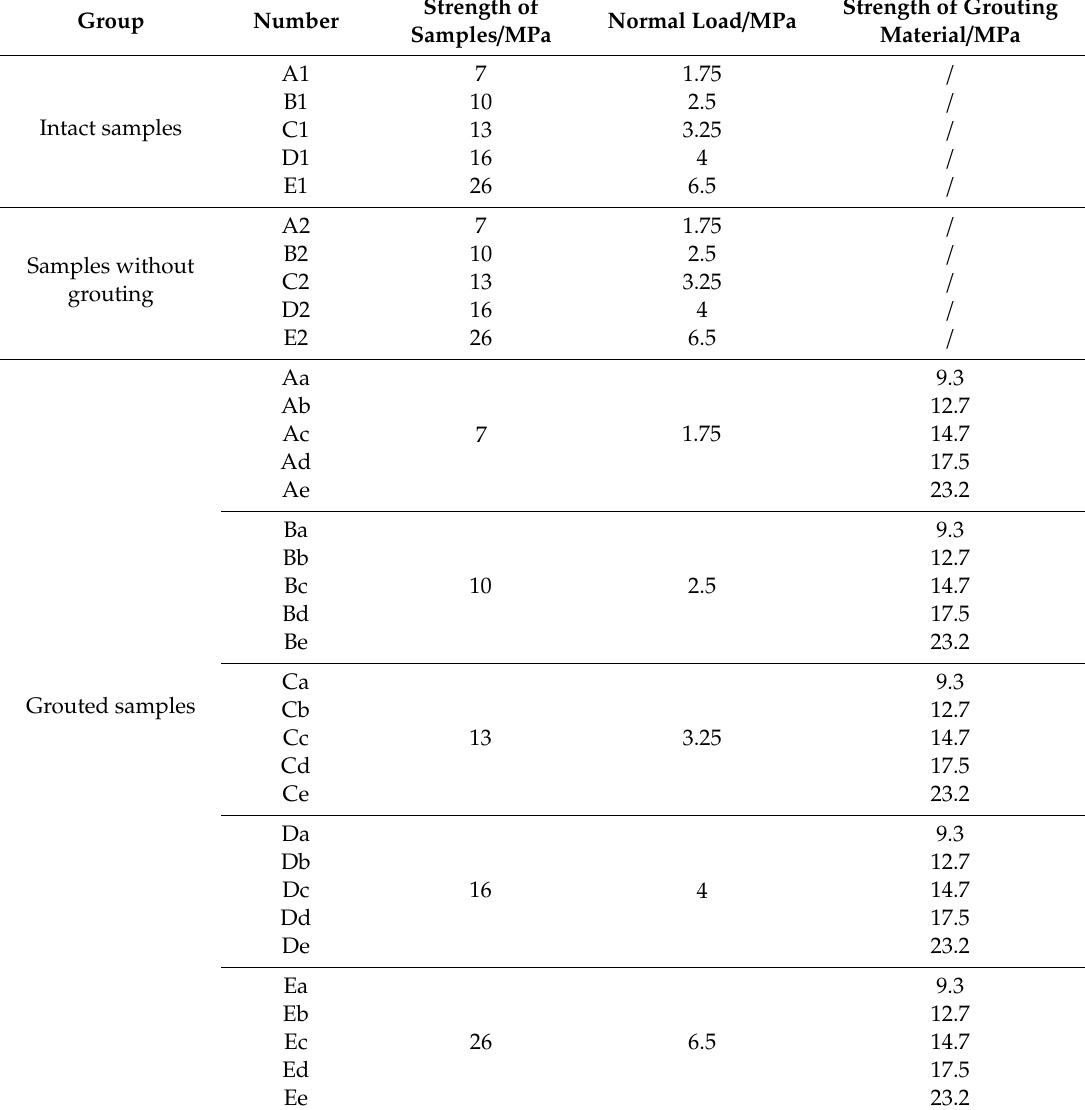
Figure 5. The test system of shearing loading of RMT-150B. Table 2. The shearing experiment scheme.